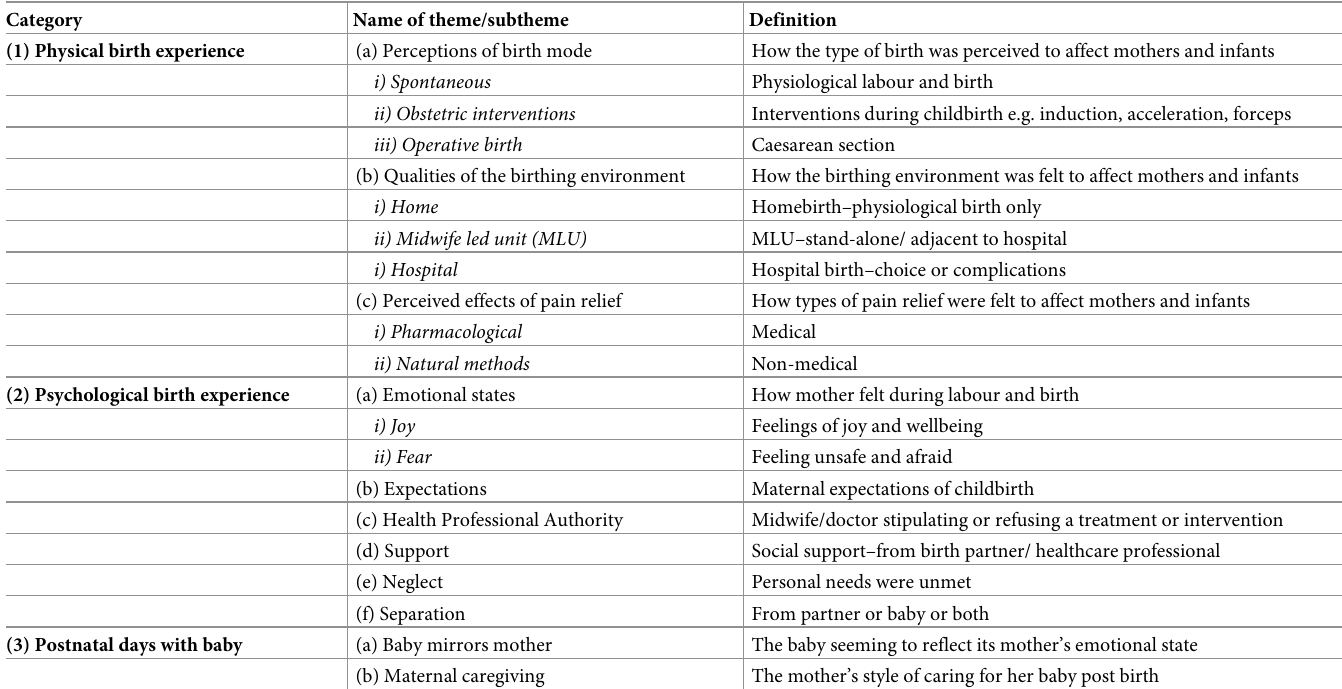
Table 3. Summary of thematic analysis: Maternal experiences of childbirth and how they felt this might have affected their baby’s early behaviour.